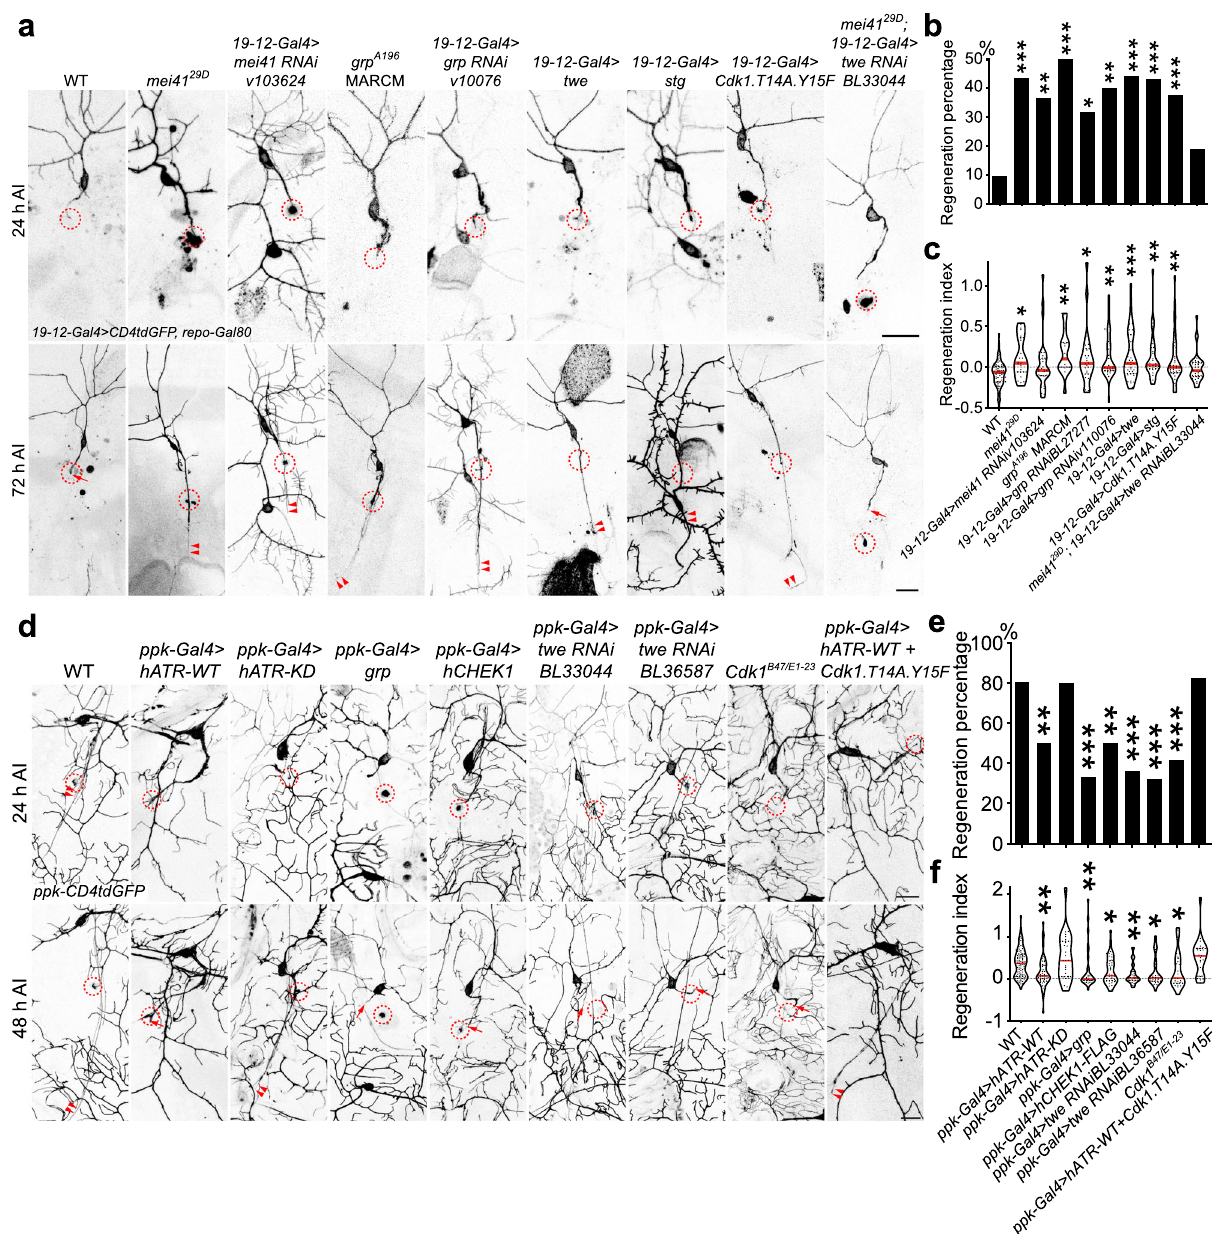
Fig. 1 The Atr/mei41-Chek1/grp pathway regulates axon regeneration in da sensory neurons in fl ies. a Class III da neuron axons fail to regenerate in WT. Atr/mei41 removal as in mei41 29D mutants or class III da neuron-speci fi c RNAi leads to increased axon regeneration. Chek1 / grp A196 mutant clones (with MARCM), class III da neuron expression of Chek1/grp RNAis, Cdc25/twe/stg, or the dephosphorylated/activated Cdk1.T14A.Y15F increases axon regeneration. Class III da neuron expression of twe RNAi suppressed the enhanced regeneration in mei41 29D mutants. The injury site is demarcated by the dashed circle. Arrow marks axon stalling while arrowheads show the regrowing axon tips. b , c Quanti fi cations of class III da neuron axon regeneration with regeneration percentage ( b ) and regeneration index ( c ). N = 72, 23, 30, 16, 22, 30, 36, 30, 37, and 28 neurons from 6 to 20 larvae. P = 0.0007, 0.003, 0.0007, 0.0177, 0.0013, <0.0001, 0.0002, 0.0008, 0.1818. d Class IV da neurons robustly regenerate in WT. Class IV da neuron-speci fi c expression